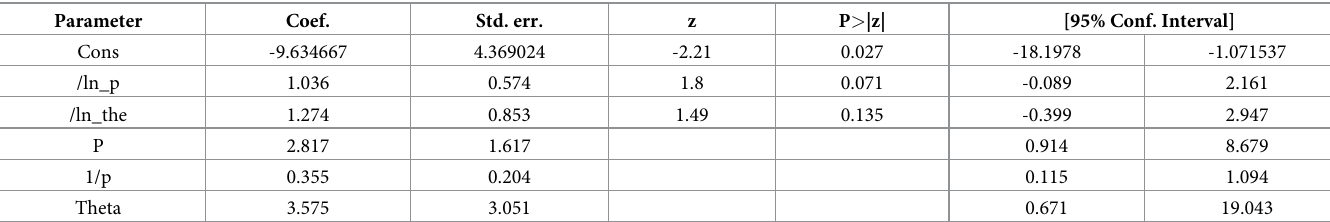
Table 4. The parameters of the classical Weibull-frailty function for the excavator failure data. Parameter Coef.